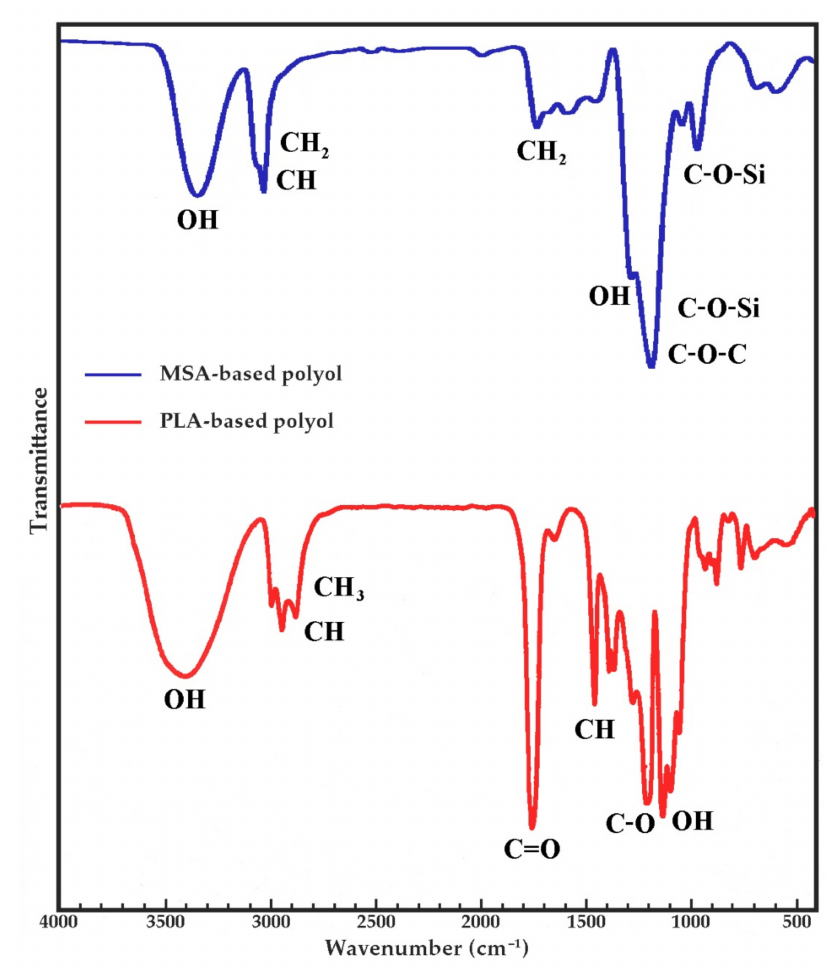
Figure 1. Fourier transform infrared (FTIR) spectra of MSA- and PLA-based